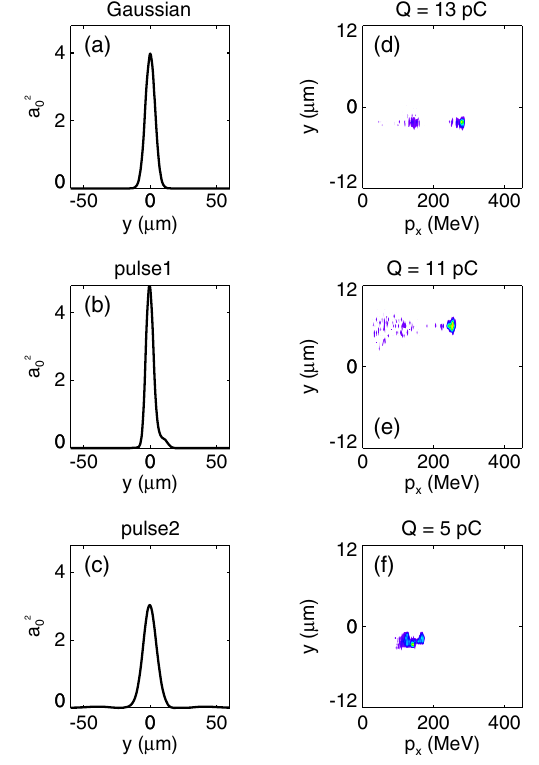
FIG. 10. Transverse laser profile for (a) the ideal Gaussian mode and (b),(c) combination of Hermite-Gaussian modes up to third order. The corresponding electron beam profile at dephasing is shown in (d) –